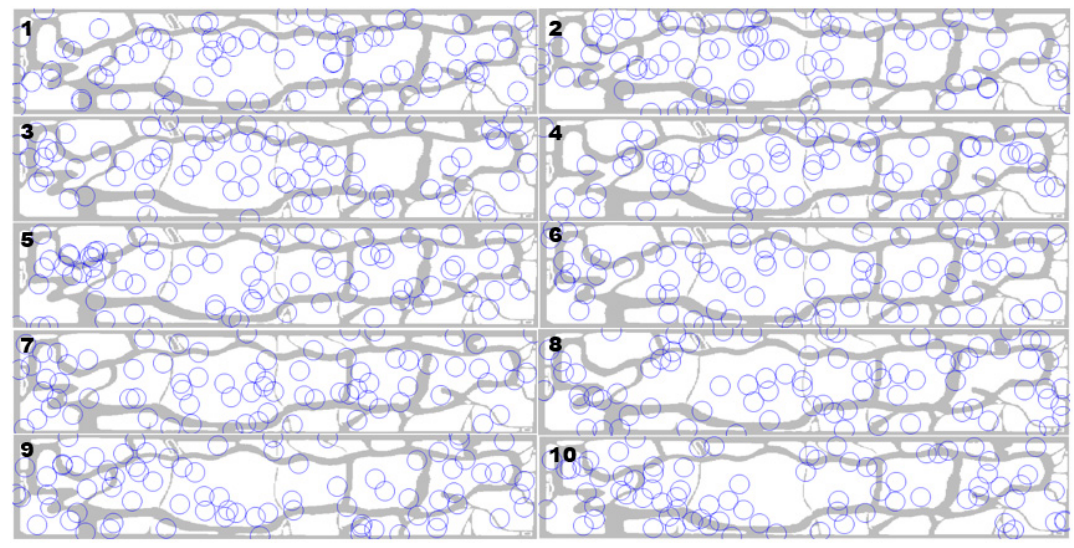
Table 3. Best 10 sensor configurations (ordered by (a) detection rate including penalties).